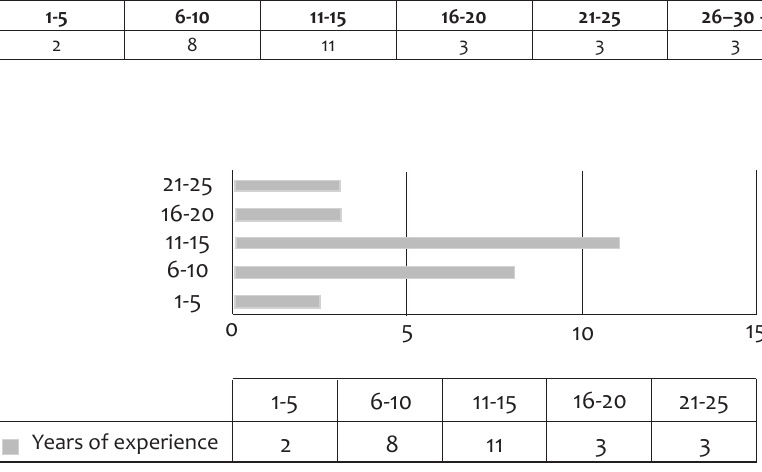
Figure 2: Teachers’ years of experience in the foundation phase.